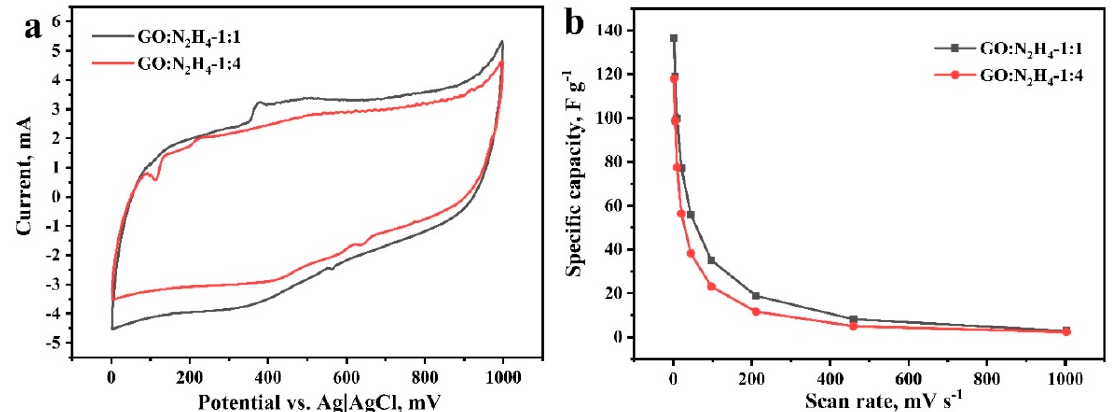
Figure 5. Cyclic voltammograms at 5 mV s -1 scan rate ( a ) and specific capacitance ( b ) of the samples